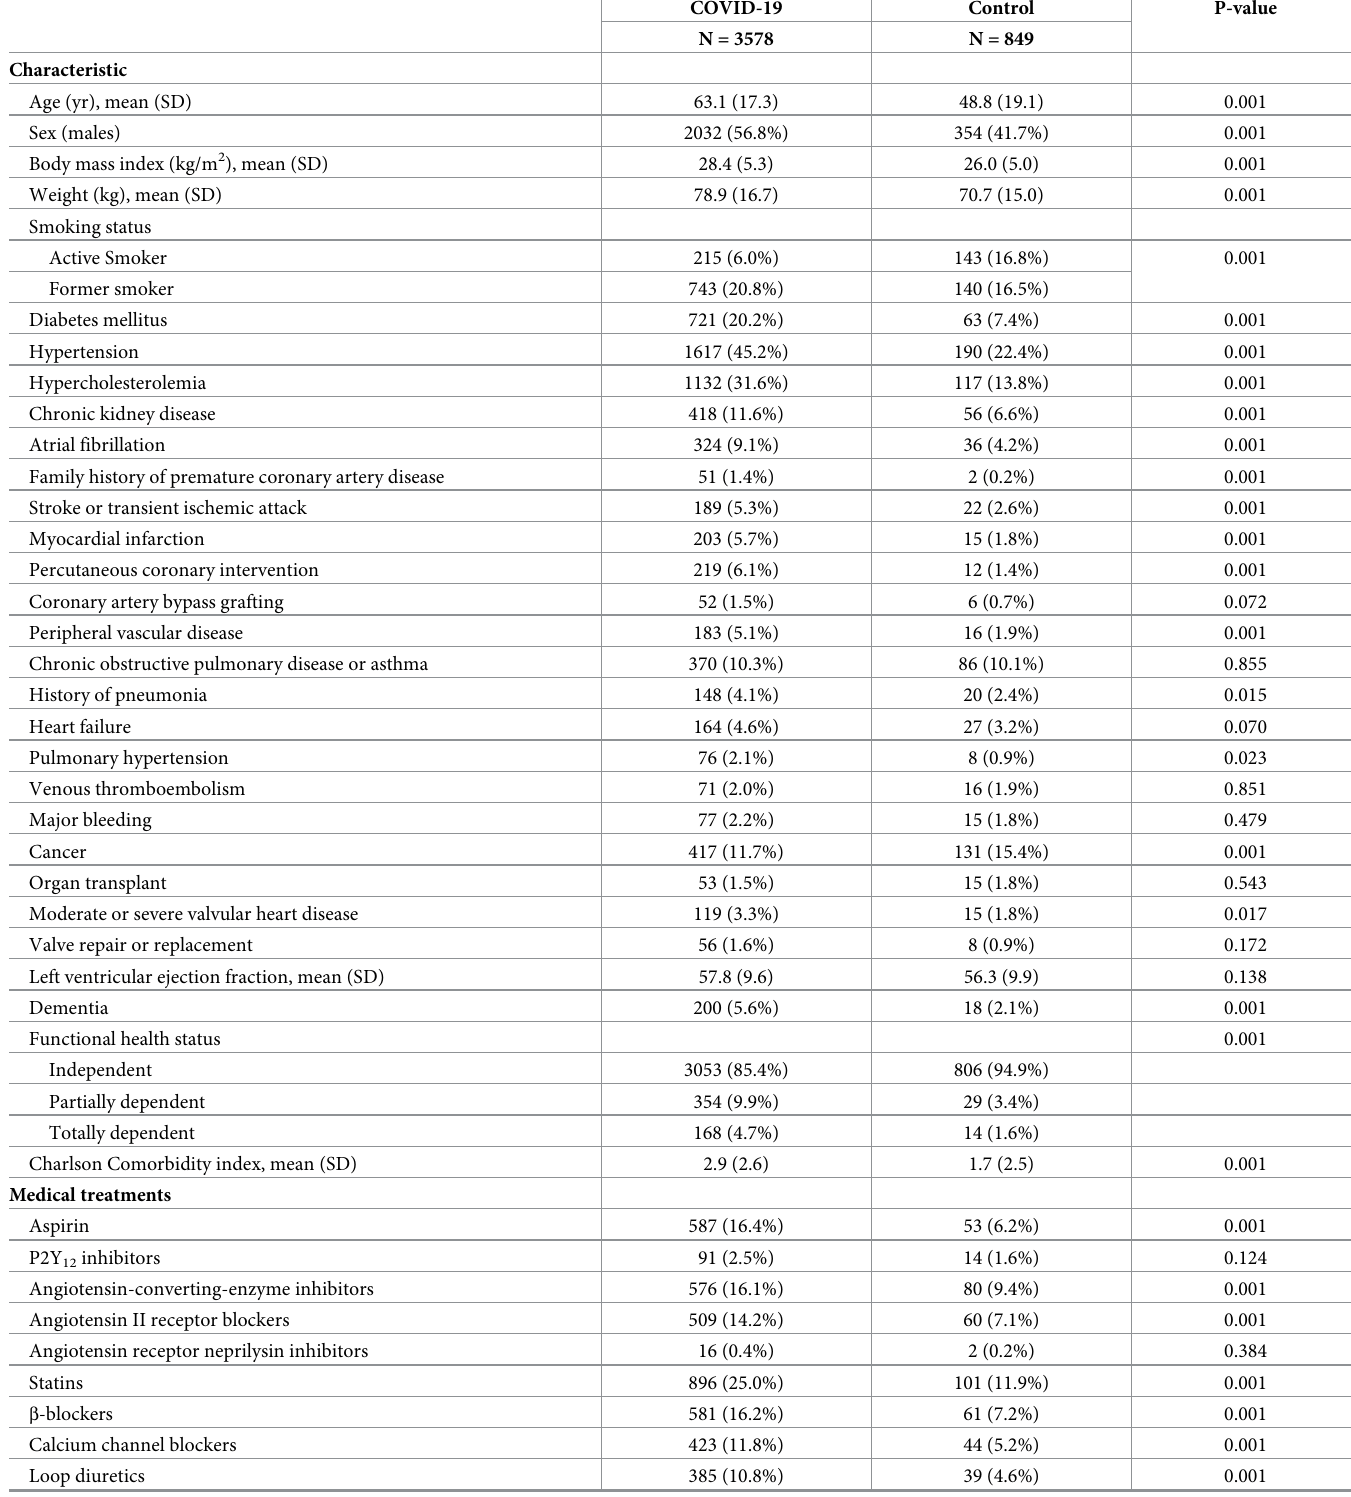
Table 1. Baseline characteristics and